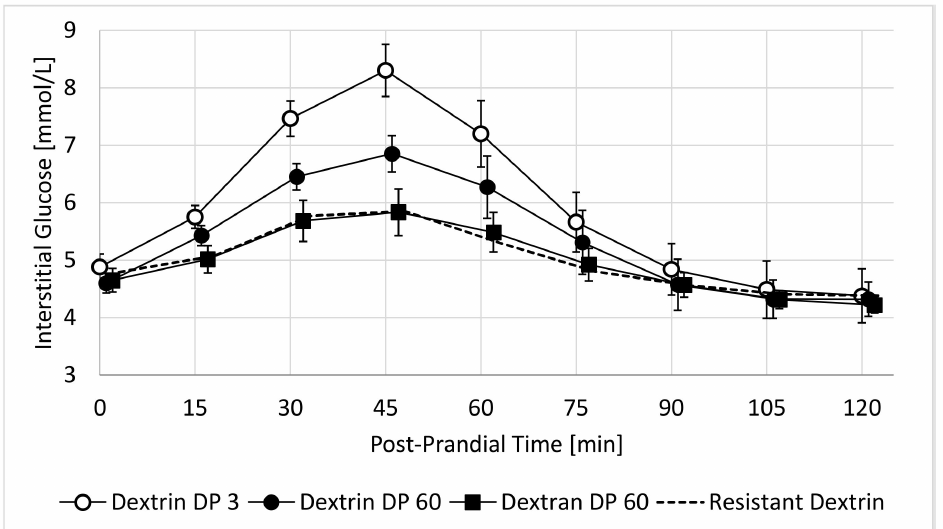
Figure 1. Average 2h-PPGR of the four test beverages featuring 25 g powder dissolved in 300 mL water. Data are shown as Mean ± SE at cross-sectional time-points every 15 min (N = 10 subjects). Endpoints derived from glucose curves are tabulated using Mean ± SE and p -values